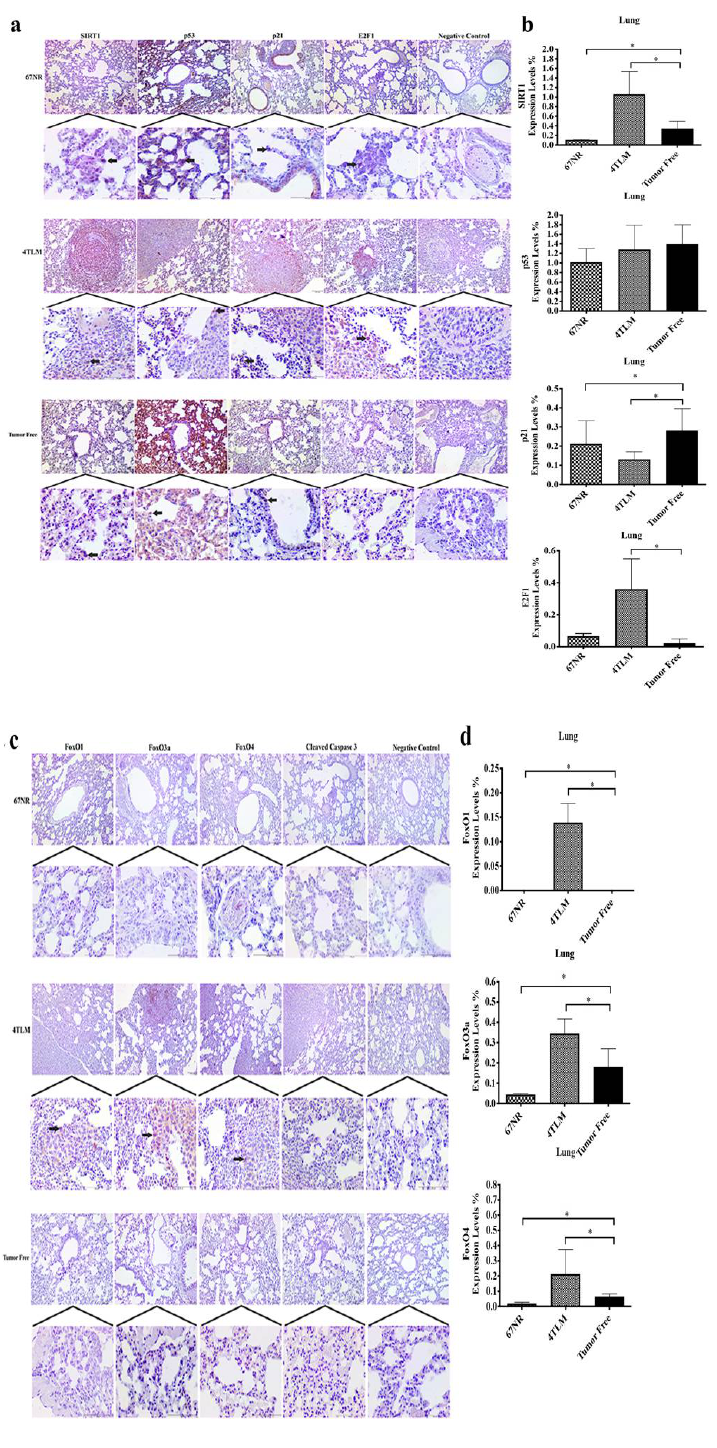
Figure 4. ( a ) Representative images of SIRT1, p53, p21 and E2F1 expression in lung tissue. Arrows represents target protein expressions for each protein in infiltrated cells. Scale bar represents 100 µ m. ( b ) Graphs demonstrate the results of Image J analysis for each protein in lung tissues (* p ˂ 0.05). There was no significant difference in p53 expression. ( c ) Representative images of FoxO1, FoxO3a, FoxO4 and cleaved caspase 3 in lung tissue. Arrows represent target protein expressions for each protein in infiltrated cells. Scale bar represents 100 μm. ( d ) Graphs demonstrate the im- munohistochemical results of Image J analysis for each FoxO protein in lung tissues (* p ˂ 0.05).